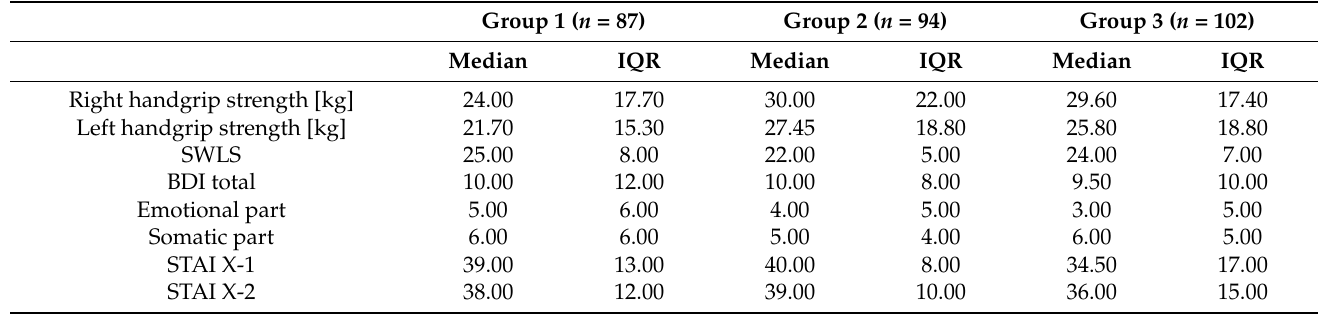
Table 5. Descriptive results of the questionnaires and tests.